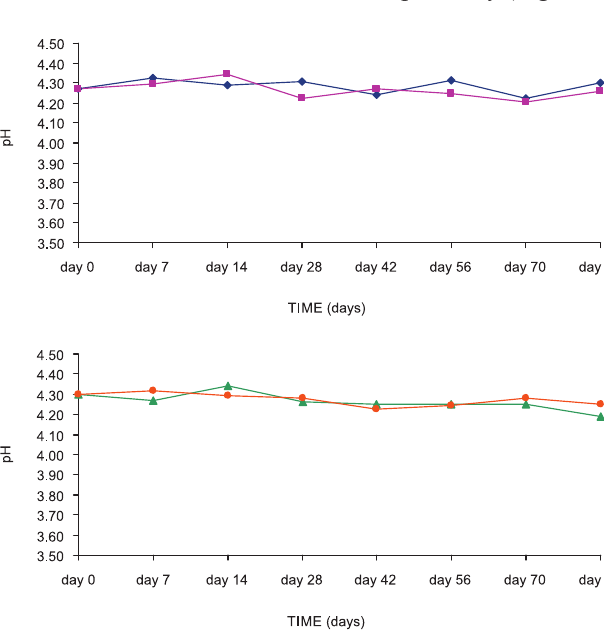
FIGURE 3 - The pH variation of sildenafil citrate syrup solutions (mean ± standard deviation; n = 3).  preservative-free solution stored at 5 ºC ± 3 ºC and  stored at 25 ºC ± 2 ºC/60% RH ± 5% RH  solution containing preservative stored at 5 ºC ± 3 ºC and  stored at 25 ºC ± 2 ºC/60% RH ± 5% RH.